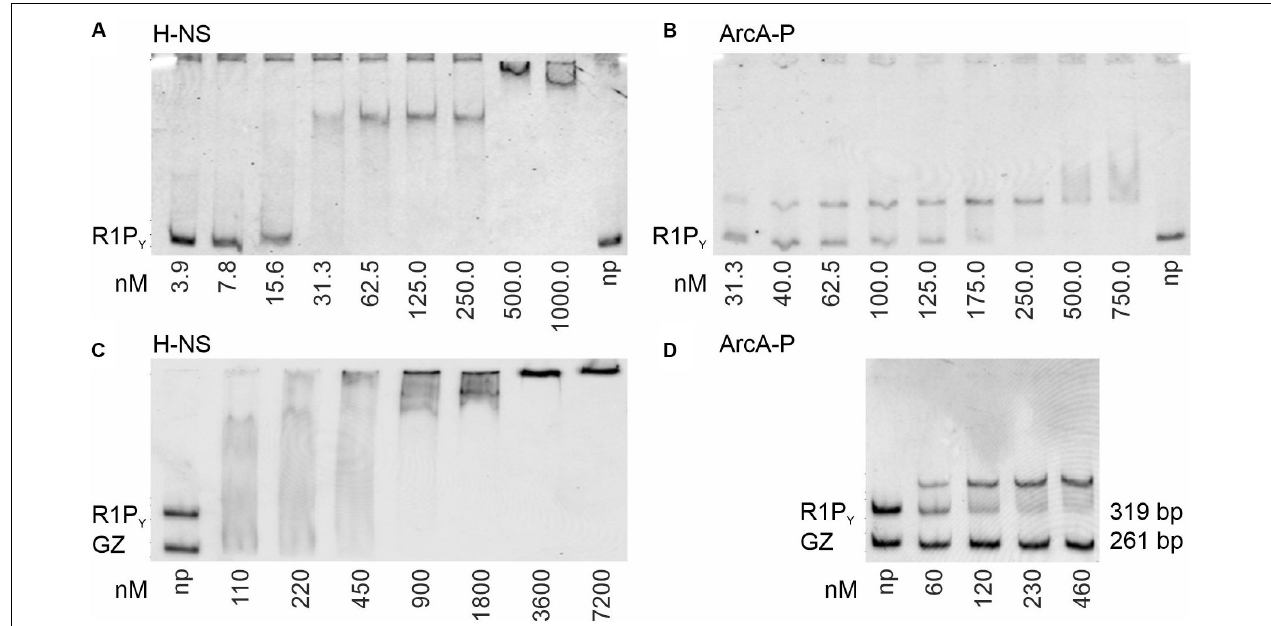
FIGURE 2 | Binding of H-NS and ArcA-P (phosphorylated ArcA) to R1P Y (319 bp, 62% AT, see Figure 1B ) and control (GZ, 261 bp, 49% AT) DNA fragments. Electrophoretic mobility shift assays (EMSAs) were performed with the indicated fluorescently Cy5-labeled ds DNA fragments (0.5 nM) and purified proteins using the indicated protein concentrations (np: no protein present). Formed DNA–protein complexes were electrophoretically separated using non-denaturing polyacrylamide gels (PAGs) from free DNA and visualized by fluorescence imaging. Free DNA fragments are indicated at the bottom of the gels. Complexes appear as distinct bands, smear, or are retained in the gel slots. To increase perceptual contrast, images were inverted (gray fluorescence signal on a white background). (A) EMSA with purified H-NS protein and R1P Y DNA. High affinity binding in with an apparent dissociation constant ( K d ) of about 15 nM can be observed. (B) EMSA with ArcA-P protein demonstrates binding of ArcA-P to R1P Y with K d of 60 nM. (C) H-NS binds to both R1P Y and GZ DNA. (D) ArcA-P is highly specific and only binds to R1P Y which contains the abs tandem repeat sequence as depicted in Figure 1C